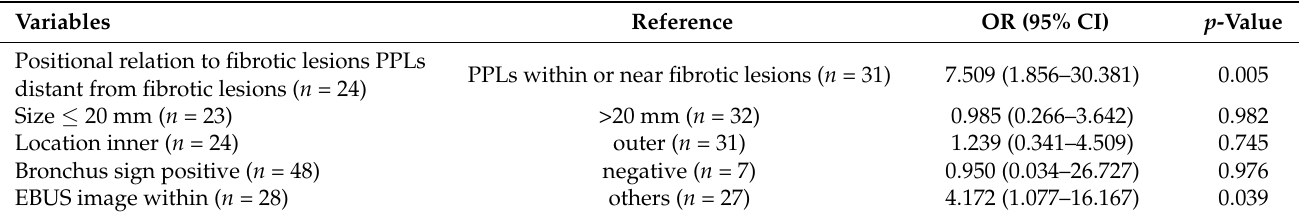
Table 3. Multivariate logistic regression analysis of factors affecting diagnostic yield using EBUS-GS TBB in patients with